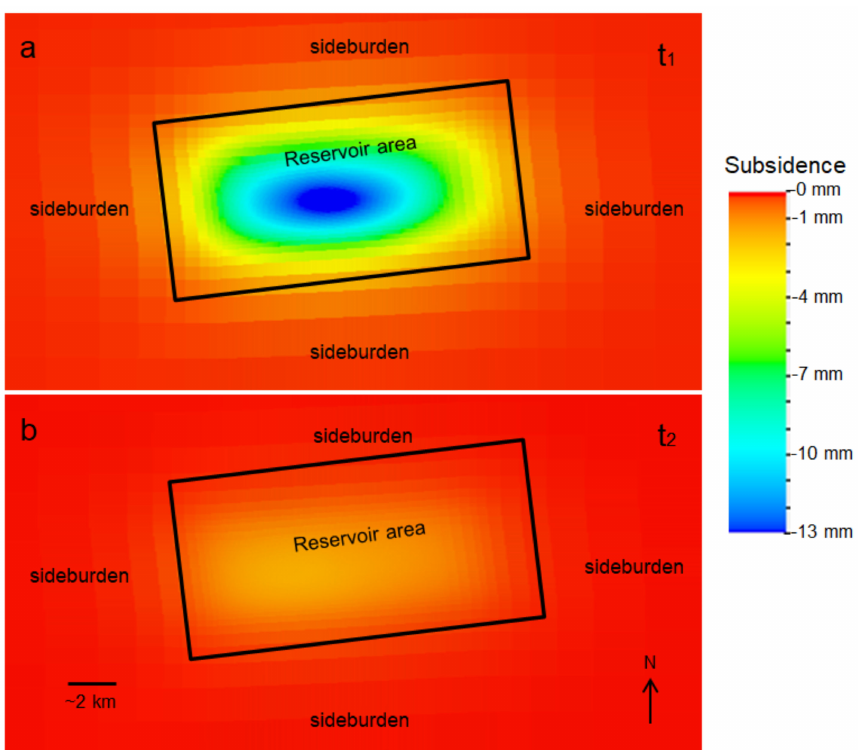
Figure 16. Subsidence predicted at the ground surface above reservoir during depletion (t1) and replenishment (t2) relative to pre-production time. The box indicates the location of the reservoir model proper embedded in the larger geomechanical model. ( a ) the maximum depletion time step; ( b ) the maximum replenishment time